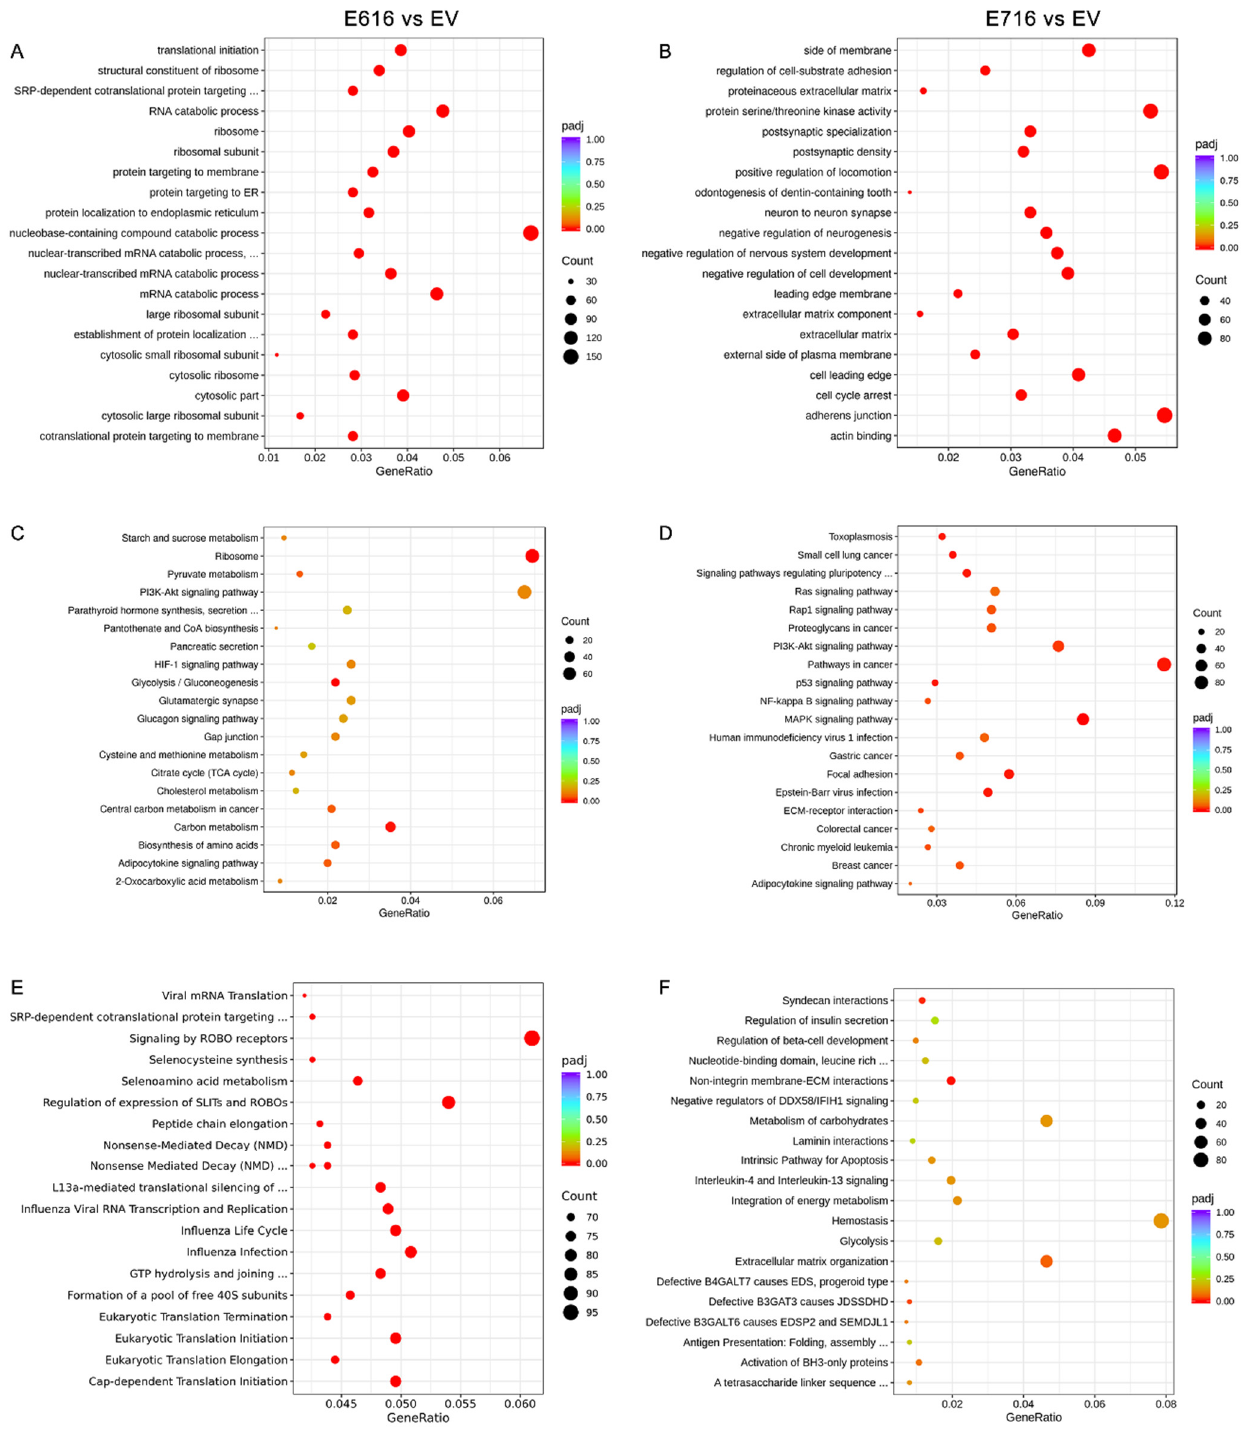
Figure 4. Enrichment analysis of differentially expressed genes (DEGs) in cells containing E616 and E716 oncoproteins. Dot plots of the 20 biological functions or pathways more significantly related with the DEGs modulated by E616 and E716 are depicted. Enrichment analysis was performed using data from GO for ( A ) E6- and ( B ) E7-expressing cells; while KEGG analysis exhibited cellular pathways affected in ( C ) E6- and ( D ) E7-containing cells. Reactome analysis showed processes associated with ( E ) E6 and ( F ) E7 expression. Significantly deregulated processes ( p -adj < 0.05) were depicted in red color. Count means the number of genes assigned to a term. GeneRatio refers to the number of observed genes (DEGs) divided by the number of expected genes related to each category.